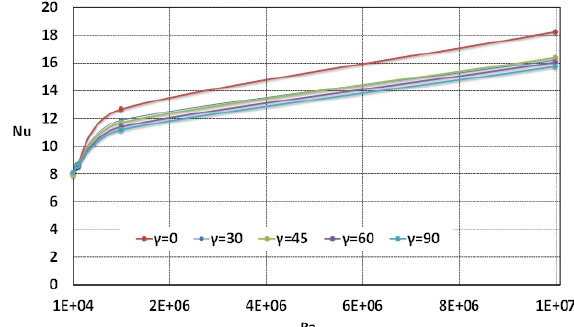
Fig. 11. Diversity of averaging Nu along heated surface with Ra for Ω = 1000 and C=0.2 number.